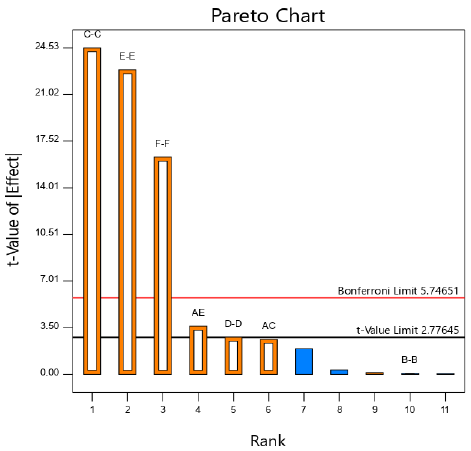
Figure 9. Pareto chart